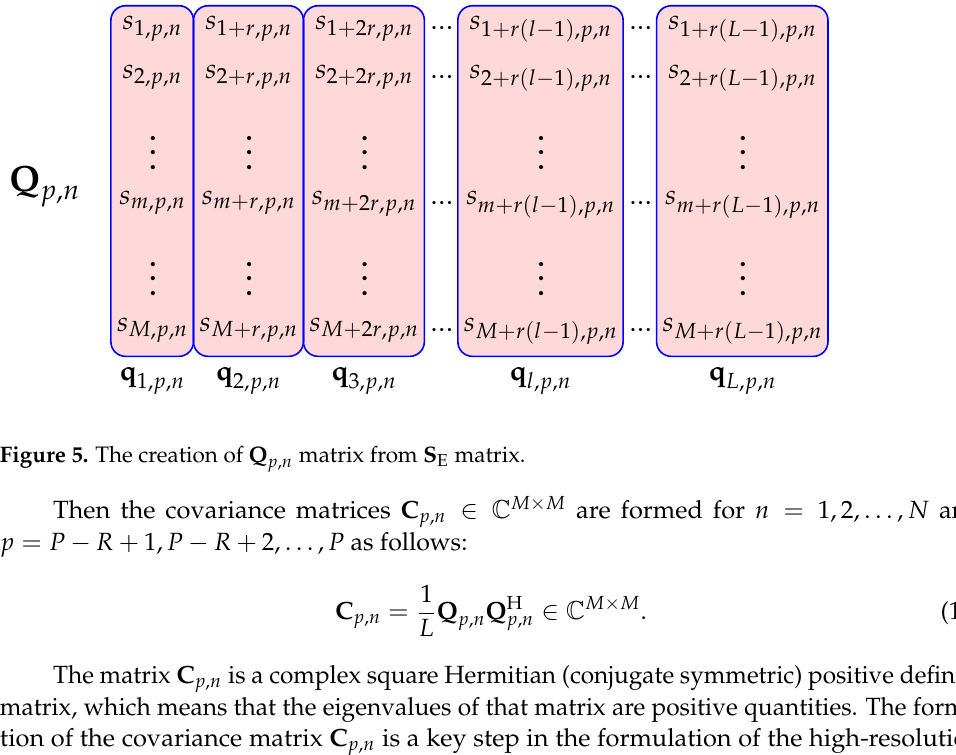
matrix from S matrix E p , n